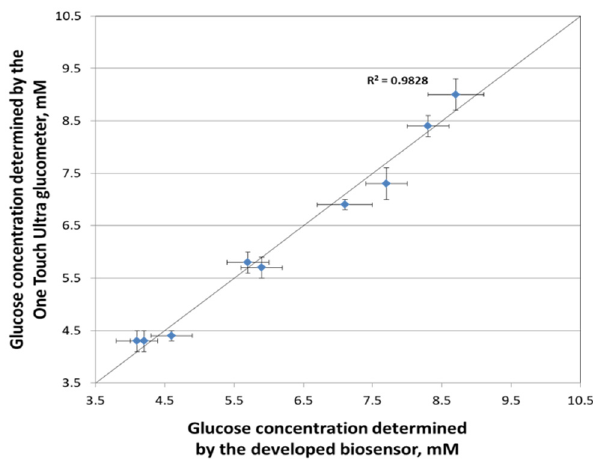
Figure 8. Determination of blood glucose content using biosensors based on the created conducting systems.